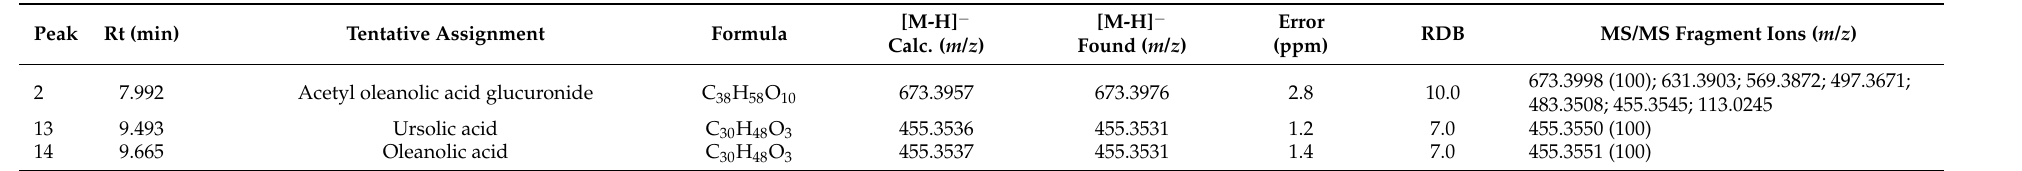
Table 4. TOF-MS and MS/MS data of triterpenes tentatively identified in apolar extracts from the different Calendula arvensis organs. Peak numbers are based on elution order in the whole reversed-phase chromatograms (RDB: ring and double